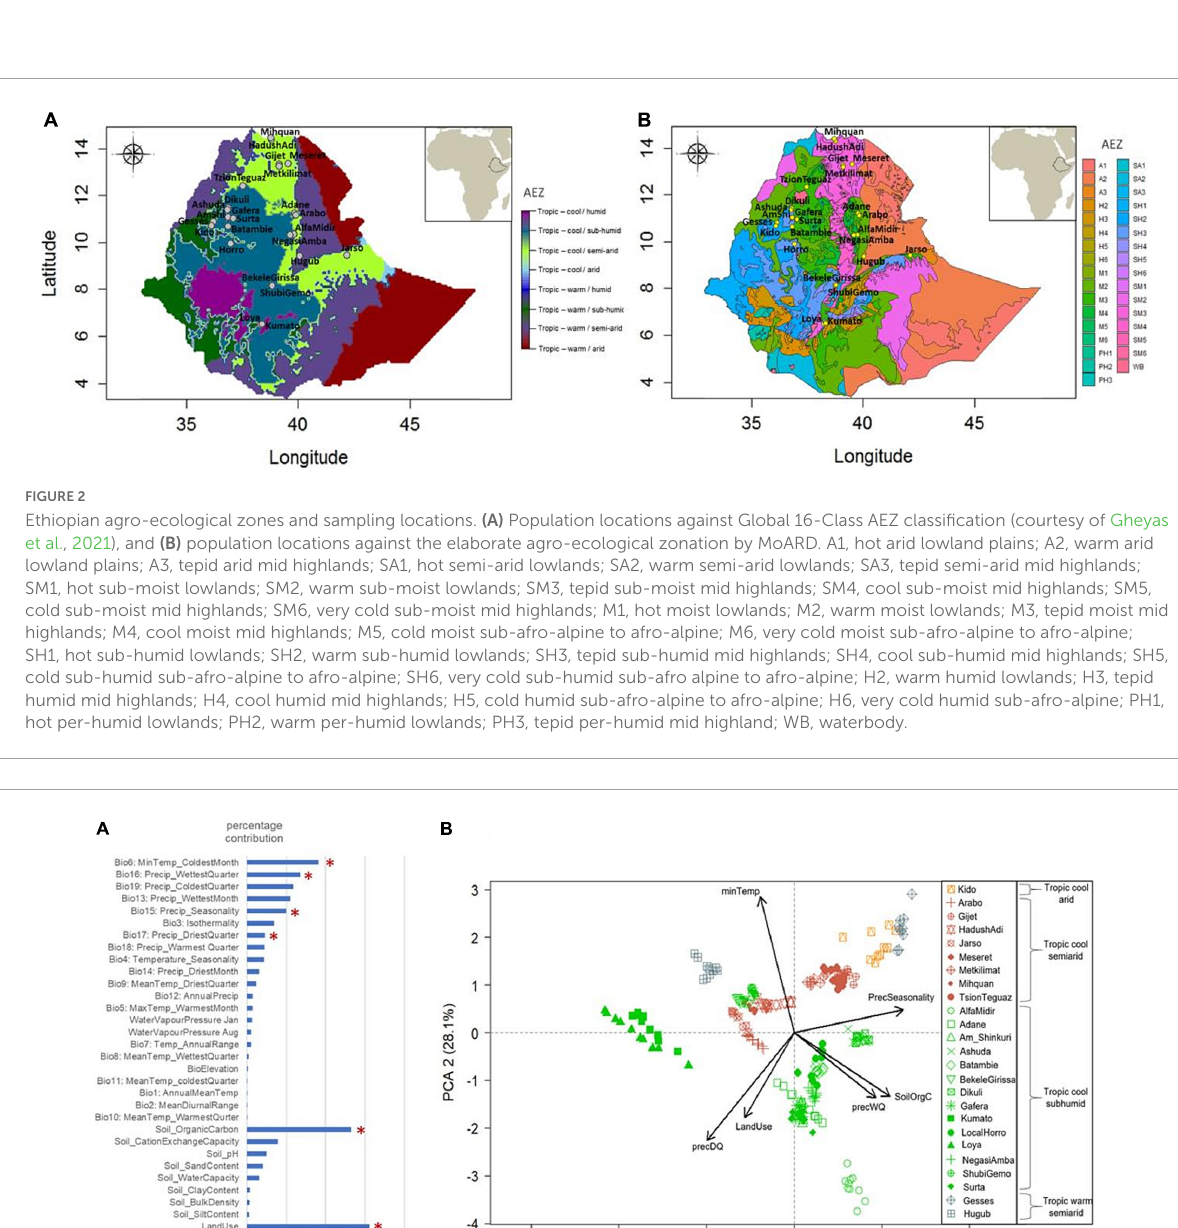
example, 14 of the 25 populations belonging to the